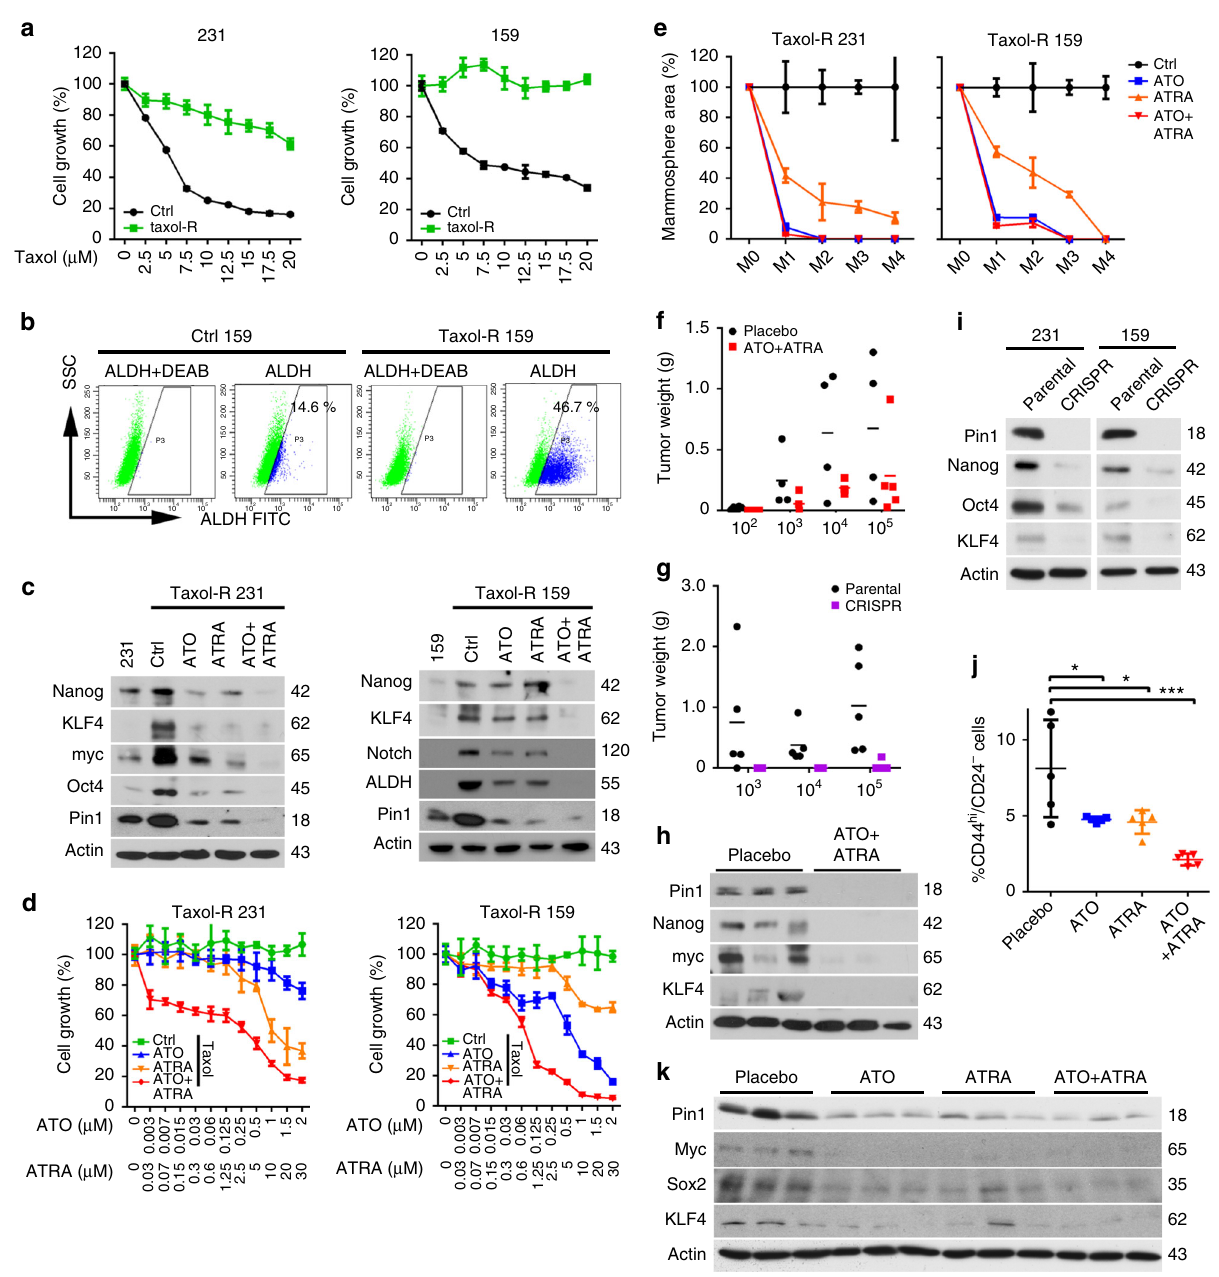
Fig. 7 ATO and ATRA cooperatively inhibit taxol resistance, tumor initiation, and tumor growth of TICs in TNBC. a Generation of taxol-resistant 231 and 159 cells by treating cells with an increasing concentration of taxol over time, followed by assaying cell growth after taxol treatment. b Taxol-resistant 159 cells have an increased population of TICs, as assayed by ALDH using FACS analysis. c – e ATO and ATRA cooperatively reduce multiple cancer stem cell regulators, cell growth, and self-renewal of taxol-resistant TNBC cells in vitro. Taxol-resistant TNBC 231 and 159 cells were treated with ATO (1 µ M) or ATRA (10 µ M) or their combination, followed by measuring selected stem cells regulators using IB ( c ), cell growth ( d ), self-renewal of TICs using serial mammosphere formation assay, followed by calculating the average area of all mammospheres formed ( e ). f – i ATO and ATRA cooperatively reduce tumor initiation and growth, and CSC regulators of TNBC cells in mice similar to Pin1 KO using CRISPR. TNBC cells were treated with ATO (1 µ M) and ATRA (10 µ M) for 3 days, followed by being injected into subcutaneous sites of nude mice in limiting dilutions and treated with ATO (2 mg/kg, i.p., 3 times/week) and ATRA (5 mg in 21-day slow release) ( f , h ). Pin1 CRISPR and vector control 231 cells were used in parallel as a control ( g , i ). Mice were sacri fi ced and evaluated for tumor weight ( f , g ), and expression of selected CSC regulators ( h ). Pin1 CRISPR cells were analyzed for CSC regulators by immunoblot ( i ). j , k ATO and ATRA cooperatively reduce TIC population and CSC regulators in PDOXs. TNBC patient-derived tumors were transplanted into cleared mouse mammary fat pads, followed by treating mice with ATO and/or ATRA or their combination for 5 weeks. Mice were sacri fi ced and evaluated for the TIC population by FACS ( j ), and selected CSC regulator expression ( k